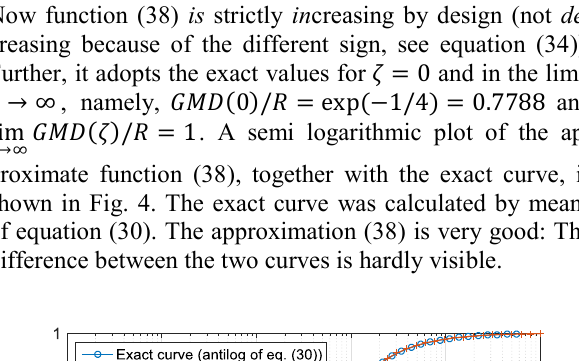
Figure 2: Semi logarithmic plot of the relative internal inductance 𝑇(𝑥) in function of the dimensionless frequency 𝑥 .